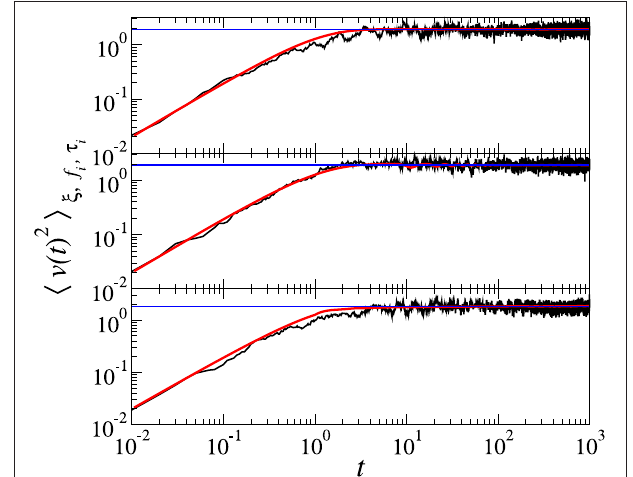
v 2 ( t ) FIGURE 3 | Relaxation dynamics of . From Top to Bottom they are e − ( τ − τ c ) 2 / 2 σ 2 τ , and h i ξ , f i , τ i ∝ the cases with f ( t ) of a poissonian, gaussian, and a power-law P ( τ ), 5, σ τ 0.5, = = respectively. The simulation data (black) were obtained by solving the Langevin Equation 1 with timestep δ t 0.01, v 0 0, and the total observation window = = T v 2 ( t ) 2000. Two theoretical lines are compared to the data: (red) = h i ξ , f i , τ i τ i obtained from Equation 17 with the additional numerical average over and { } the stationary value (blue) Equation 18. In the simulation, we used the β γ parameters: m 1, τ c 10 and σ τ 1 for the poissonian and = = = = = gaussian PDFs, and α 1.2 (producing [ τ ] T 5.7) for the power-law PDF. For = = all cases, P ( f ) is a uniform distribution in [ −√ 3, √ 3]. The units in our Langevin m / ( βσ ). simulation of Equation 1 are: [ x ] 1 / √ βσ , [ t ] = = p